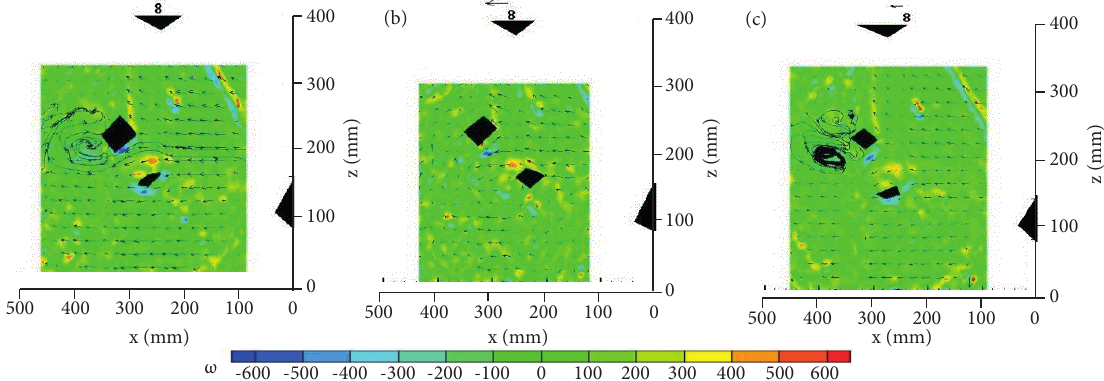
Figure 23. Vorticity contours and velocity vectors varying the coastal cliff inclination with y/L = 0.68, α = 35° and Re = 1.7 × 10 5 . (a) β = 45°; (b) β = 90°; (c) β = 70°.